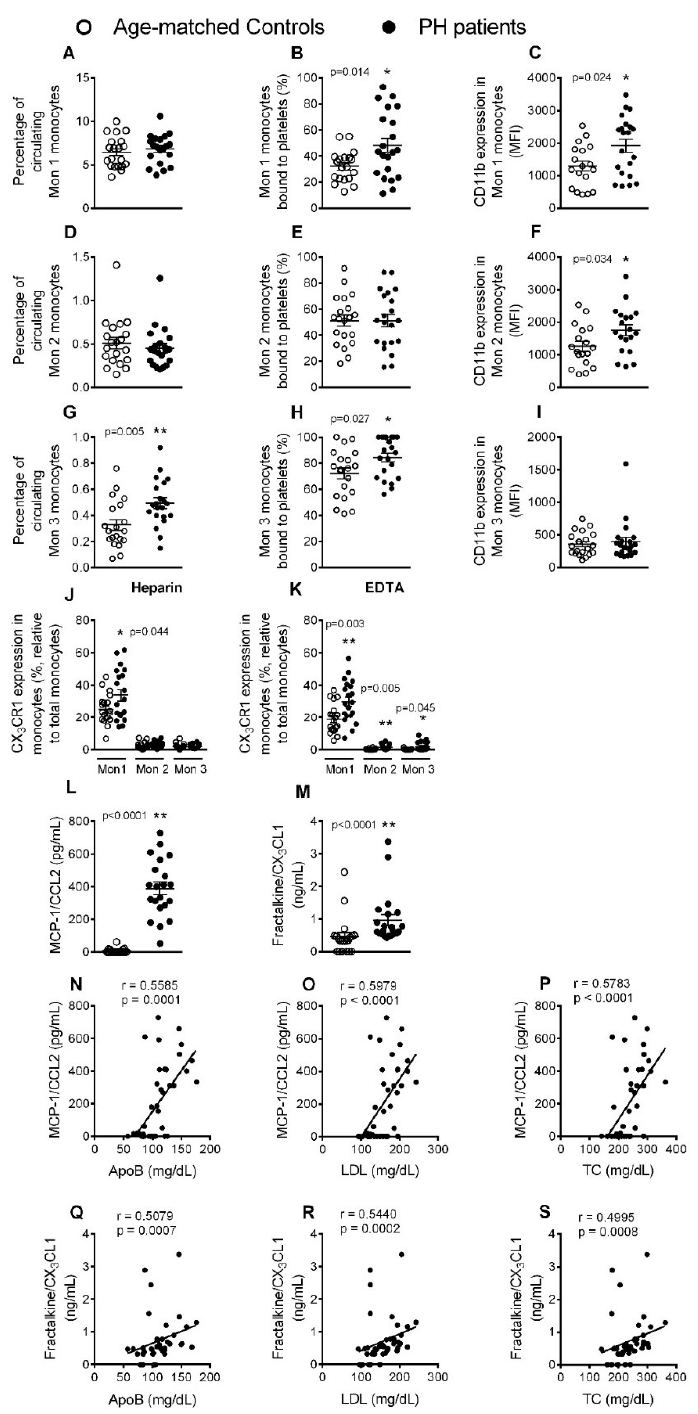
Figure 3. The percentage of circulating Mon 3 monocytes, platelet-Mon 1 and 3 aggregates, activated Mon 1 and 2 monocytes, and plasma levels of CCL2 and CX 3 CL1, are elevated in patients with PH. Flow cytometry analysis of heparinized whole blood co-stained with specific markers for platelets and Mon 1, 2 and 3 monocytes ( A , B , D , E , G , H ), CD11b integrin ( C , F and I ), and also for CX 3 CR1 in heparinized and EDTA-treated whole blood ( J and K ). Results are expressed as percentage of positive cells or mean fluorescence intensity (MFI). MCP-1/CCL2 ( L ) and fractalkine/CX 3 CL1 ( M ) plasma levels (pg or ng/mL) were measured by ELISA ( n = 21 control subjects and n = 22 PH patients). Values are expressed as mean ± SEM. * p < 0.05 or ** p < 0.01 relative to values in the control group. Correlations between circulating MCP-1/CCL2 or fractalkine/CX 3 CL1 and ApoB ( N and Q ), LDL ( O and R ) and TC ( P and S ) plasma levels.